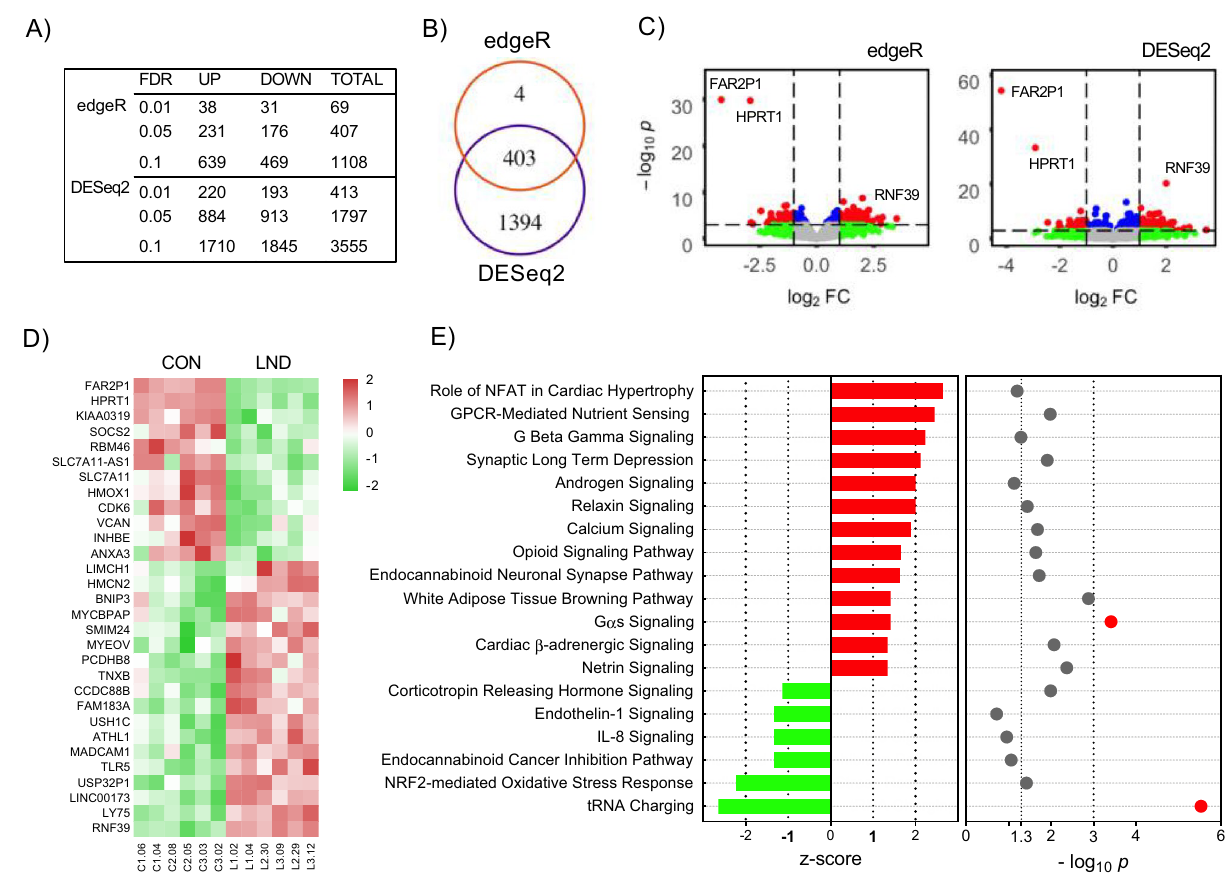
Figure 3. Transcriptome analysis. Gene expression profiles were evaluated by RNAseq for all LND (n = 6) and control (n = 6) lines. Differential gene expression differed according to both analytical method (edgeR, DESeq2) and statistical threshold ( A ). However, 403 genes were differentially expressed using both methods at FDR < 0.05 ( B ). For both edgeR and DESeq2 methods, volcano plots ( C ) consistently demonstrate 2 genes to be expressed at markedly lower levels in the LND lines ( HPRT1 and FAR2P1 ), and 1 gene to be expressed at higher levels in the LND lines ( RNF39 ). The red color shows genes with FDR < 0.05 and fold change > 2. The blue color shows genes with FDR < 0.05 and fold change < 2. Green and gray show gene changes with FDR > 0.05. Individual variation among the lines is shown as a heatmap of gene expression ( D ). Red depicts higher gene expression and green depicts lower expression. Considering only the 403 genes differentially expressed using both edgeR and DESeq2 at FDR < 0.05, 19 pathways appeared to be significantly different when comparing the LND and control lines ( E ). Red bars depict positive z-scores while green depict negative z-scores. Red dots represent p-values < 0.001 (i.e. − log10(.001) >